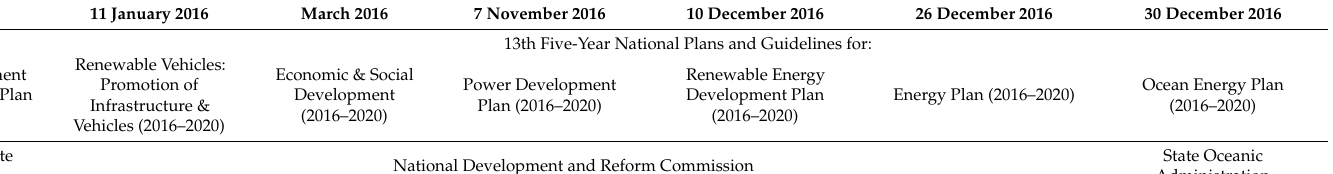
Table 2. Overview of national energy development–related policies toward 2020.